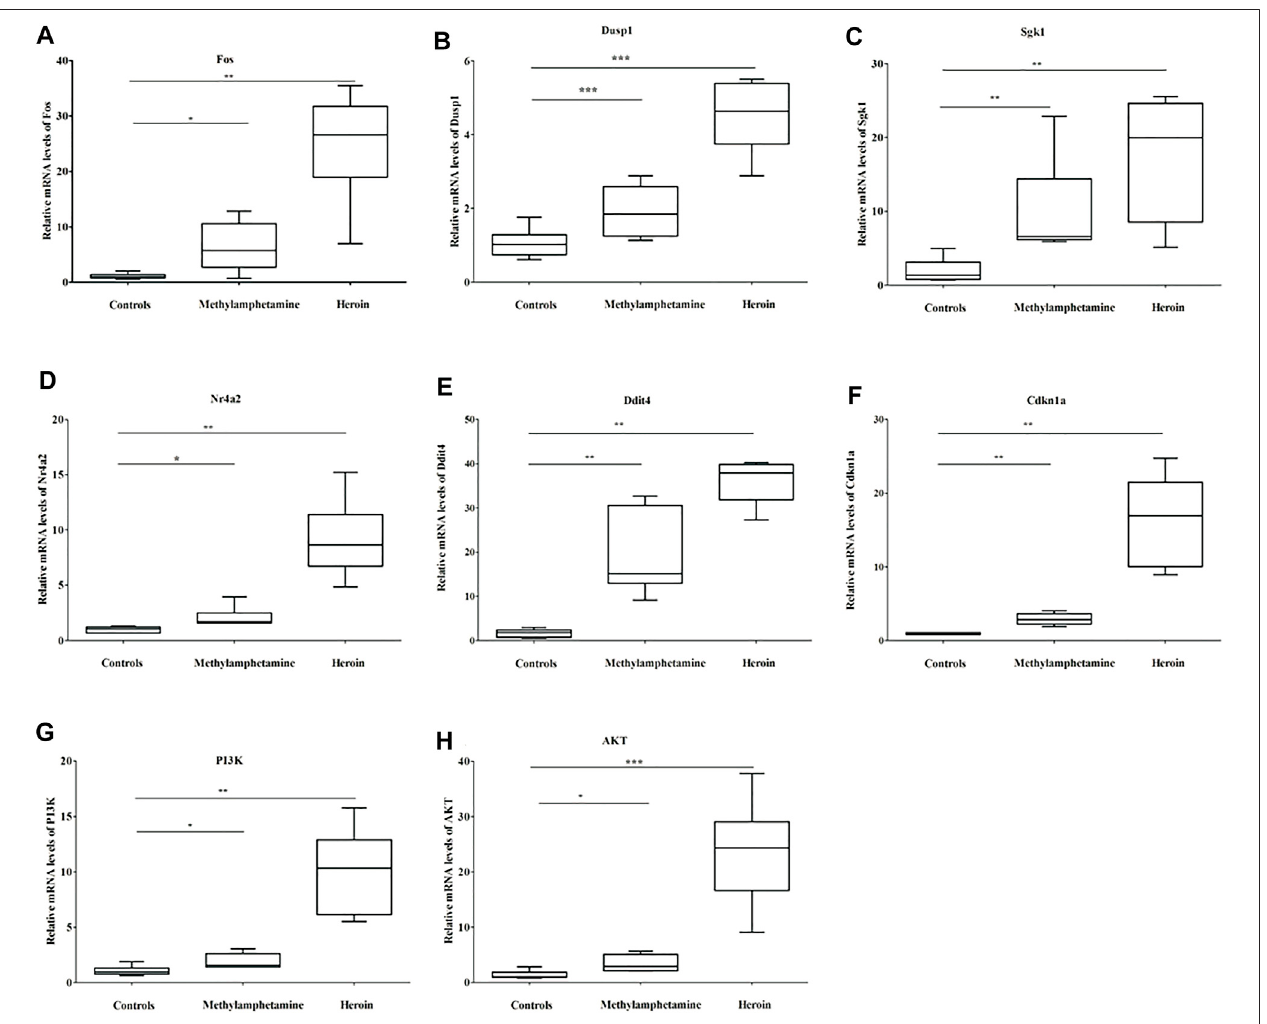
FIGURE 6 | The relative mRNA levels of Fos (A) , Dusp1 (B) , Sgk1 (C) , Nr4a2 (D) , Ddit4 (E) , Cdkn1a (F) , PI3K (G) , and Akt (H) in BV2 cells treated with 1,000 μ M METH and 200 μ M heroin after 24 h, respectively (* p ＜ 0.05, ** p ＜ 0.01, *** p ＜ 0.001 compared with the